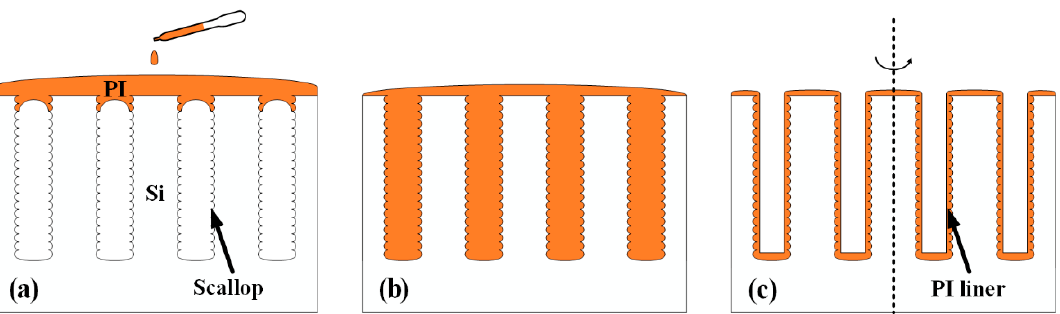
Figure 2. Schematic of the vacuum-assisted spin coating technique: ( a ) dispensing of PI, ( b ) vacuum treatment, ( c ) spin coating of PI. treatment, ( c ) spin coating of